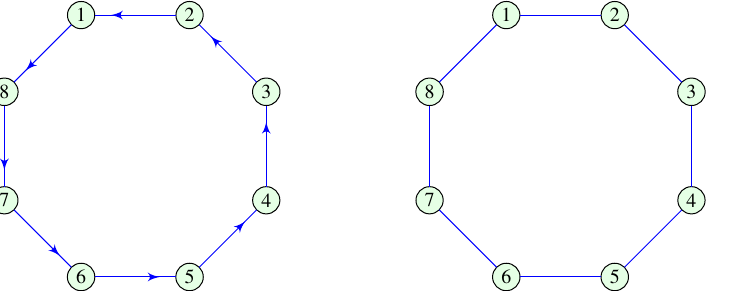
Figure 1. Time domain of periodic signals presented as: Circular unweighted directed graph ( left ) and an undirected graph ( right ), with N = 8 vertices